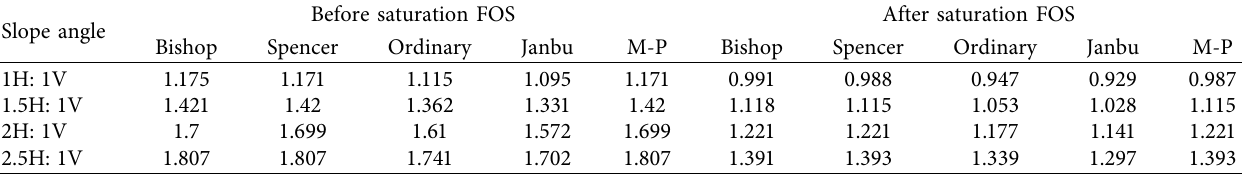
Table 9: FOS values for slope-2 for different slope angles before and after saturation.